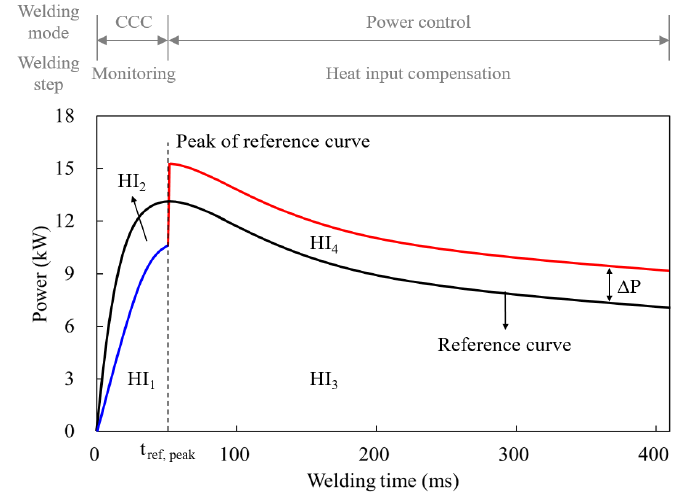
Figure 14. Relationship between the β - peak and the monitoring and welding control times.